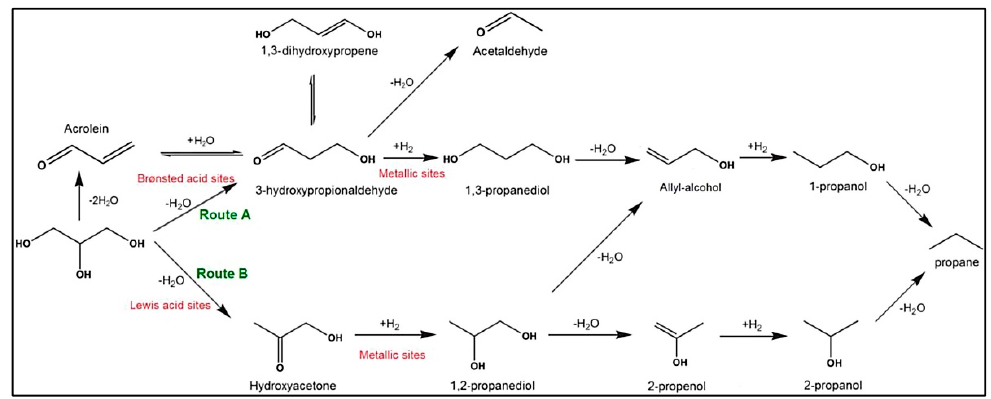
Figure 6. Expanded mechanism for the glycerol hydrogenolysis reaction using an acid-based catalyst. Reprinted/adapted with permission from da Silva Ruy et al. [95], Elsevier, 2020.